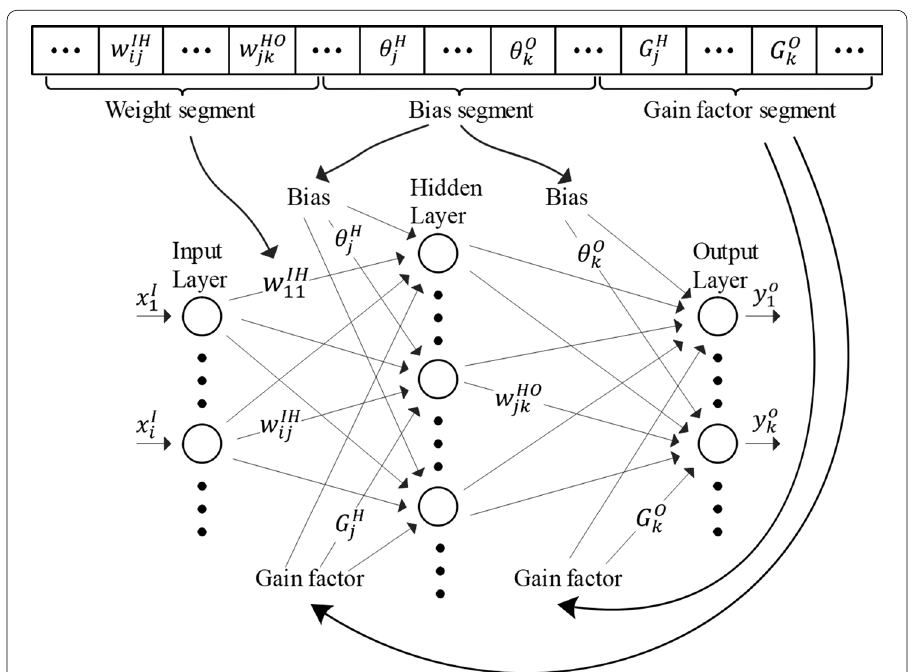
Fig. 2 The chromosome represents the neural network